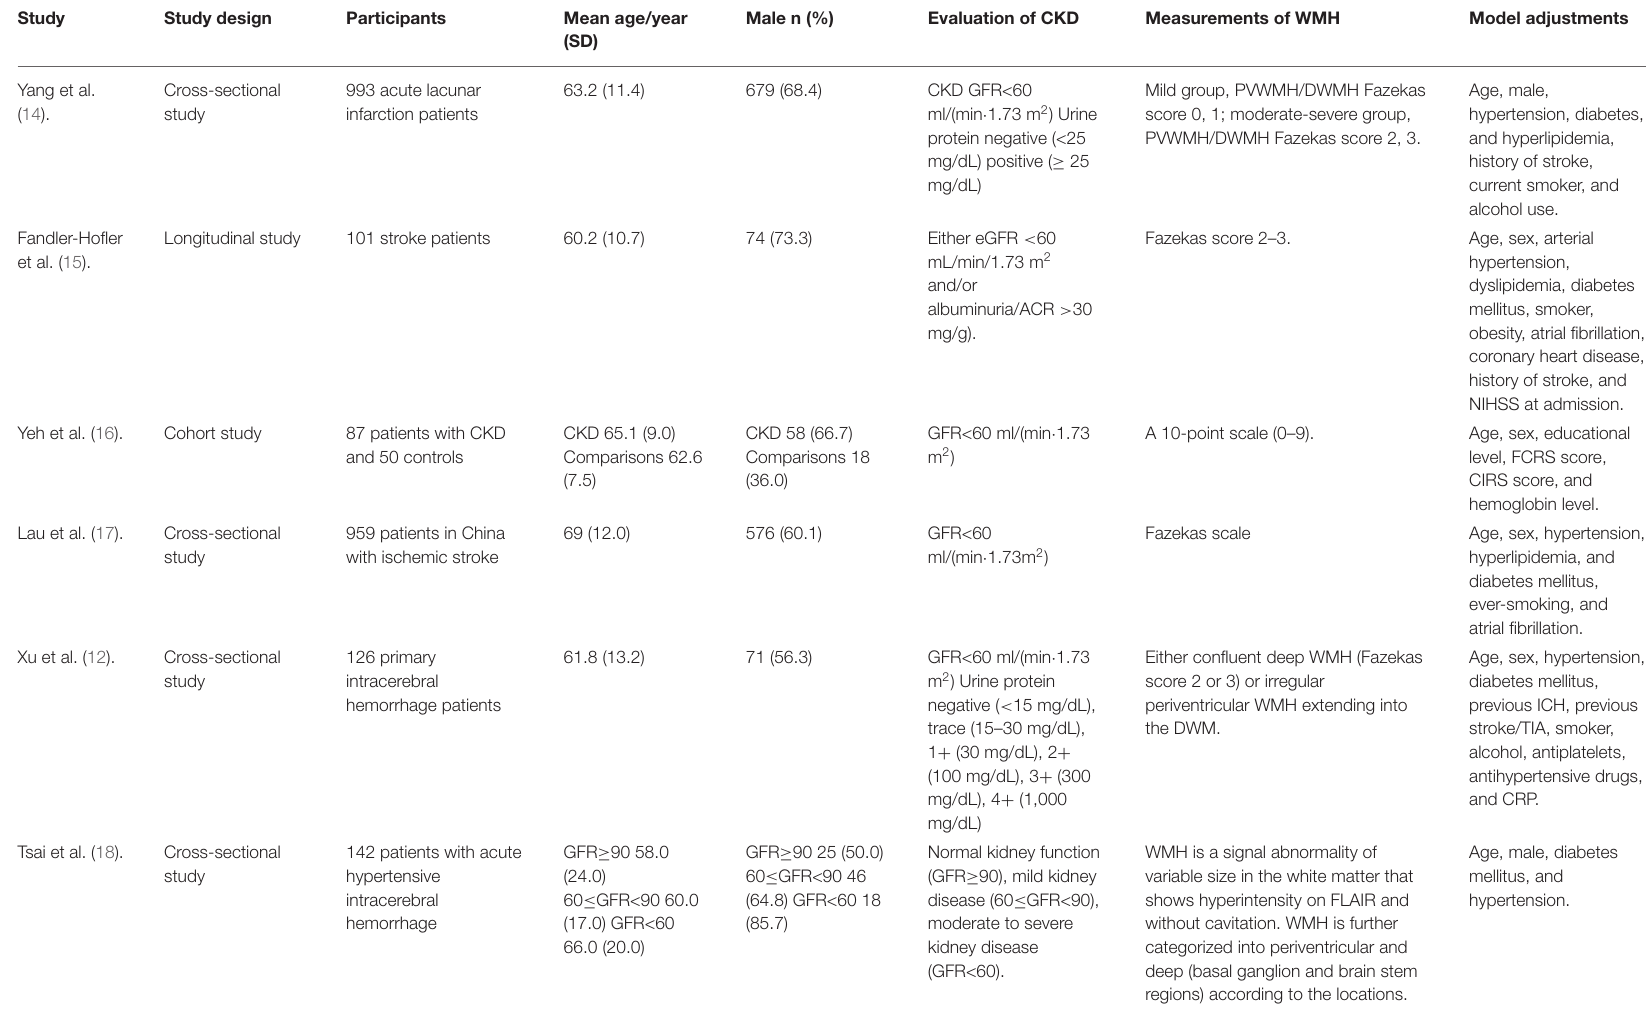
TABLE 1 | Characteristics of included